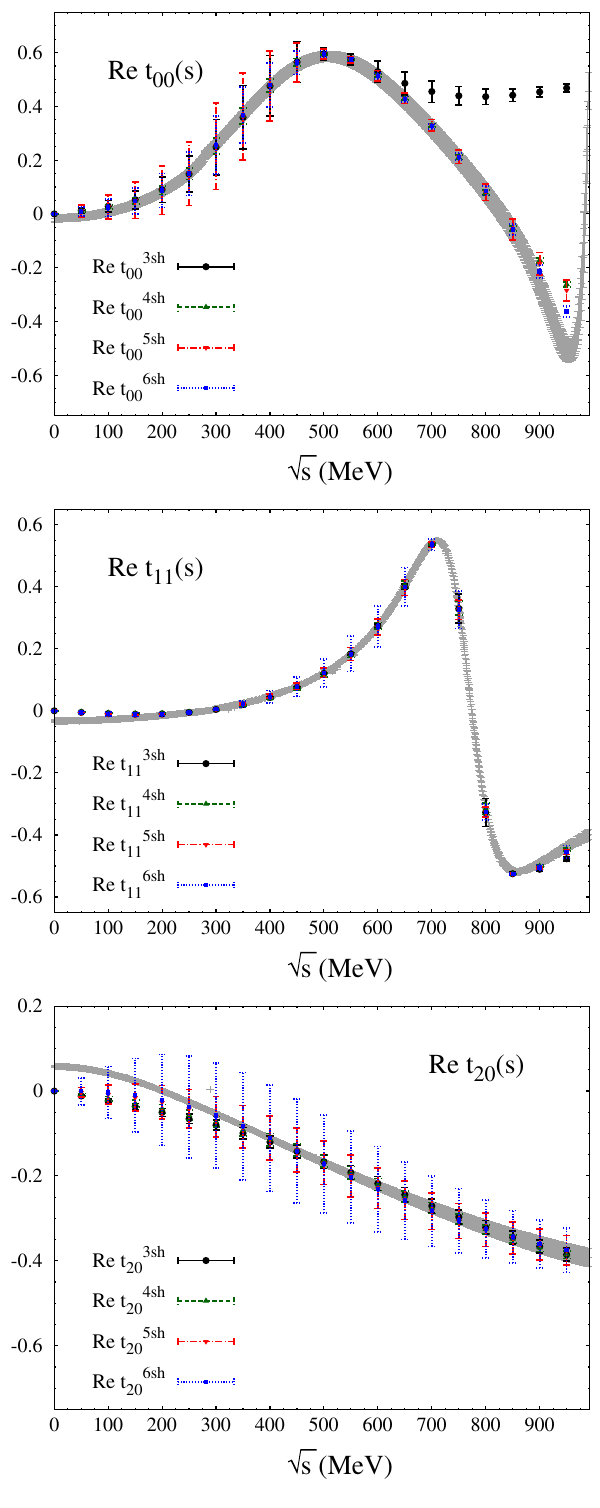
Fig. 7 Real ππ partial-wave amplitudes as a function of the CM √ s = 0 for I = 0 (top), energy, starting from the subthreshold value I = 1 (middle) and I = 2 (bottom). We compare the different delta- shell results with the results of the Roy-equation analysis (gray